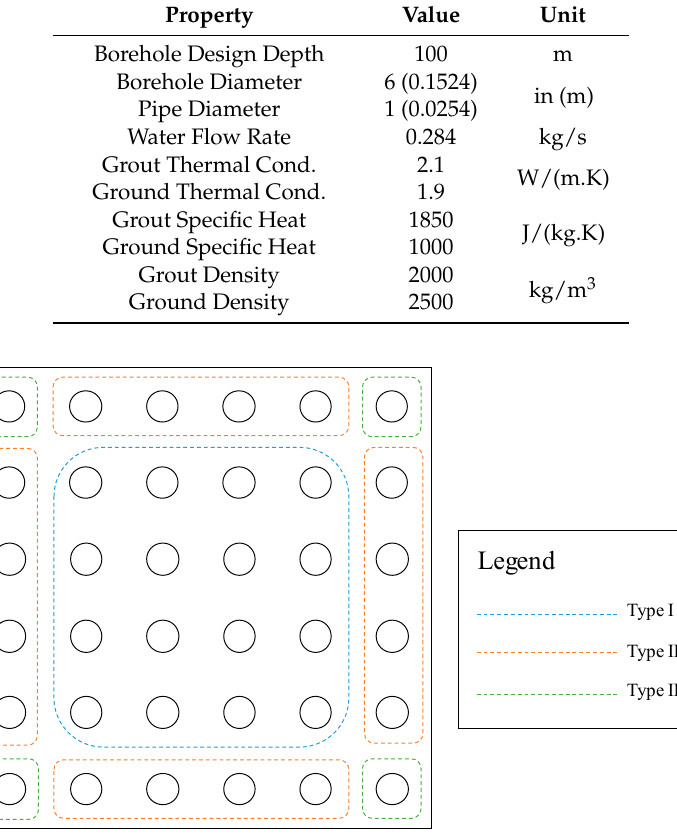
Figure 4. Schematic of the 6 × 6 borehole grid selected with different borehole types highlighted.